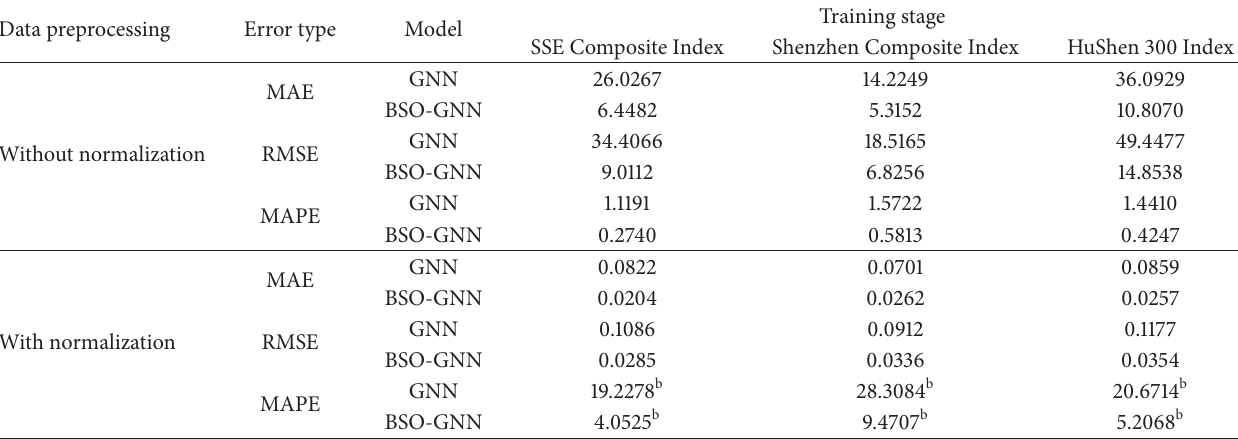
Table 3: Fitting error results of different models under different data preprocessing